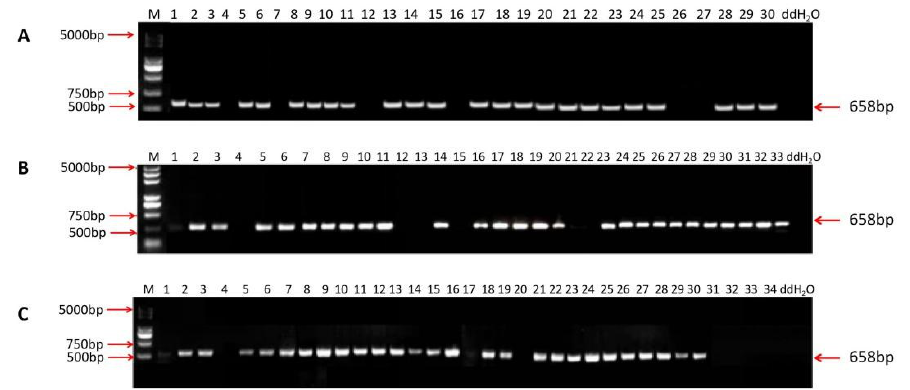
Figure 4. Amplification results of T 0 generation transformed plants of MMB ( A ), TKB ( B ), and DR462 ( C ). M: DL 5000 DNA Marker; ddH2O: a negative control based on sterile water; 5000 bp, 750 bp, 500 bp, 658 bp: fragment size.